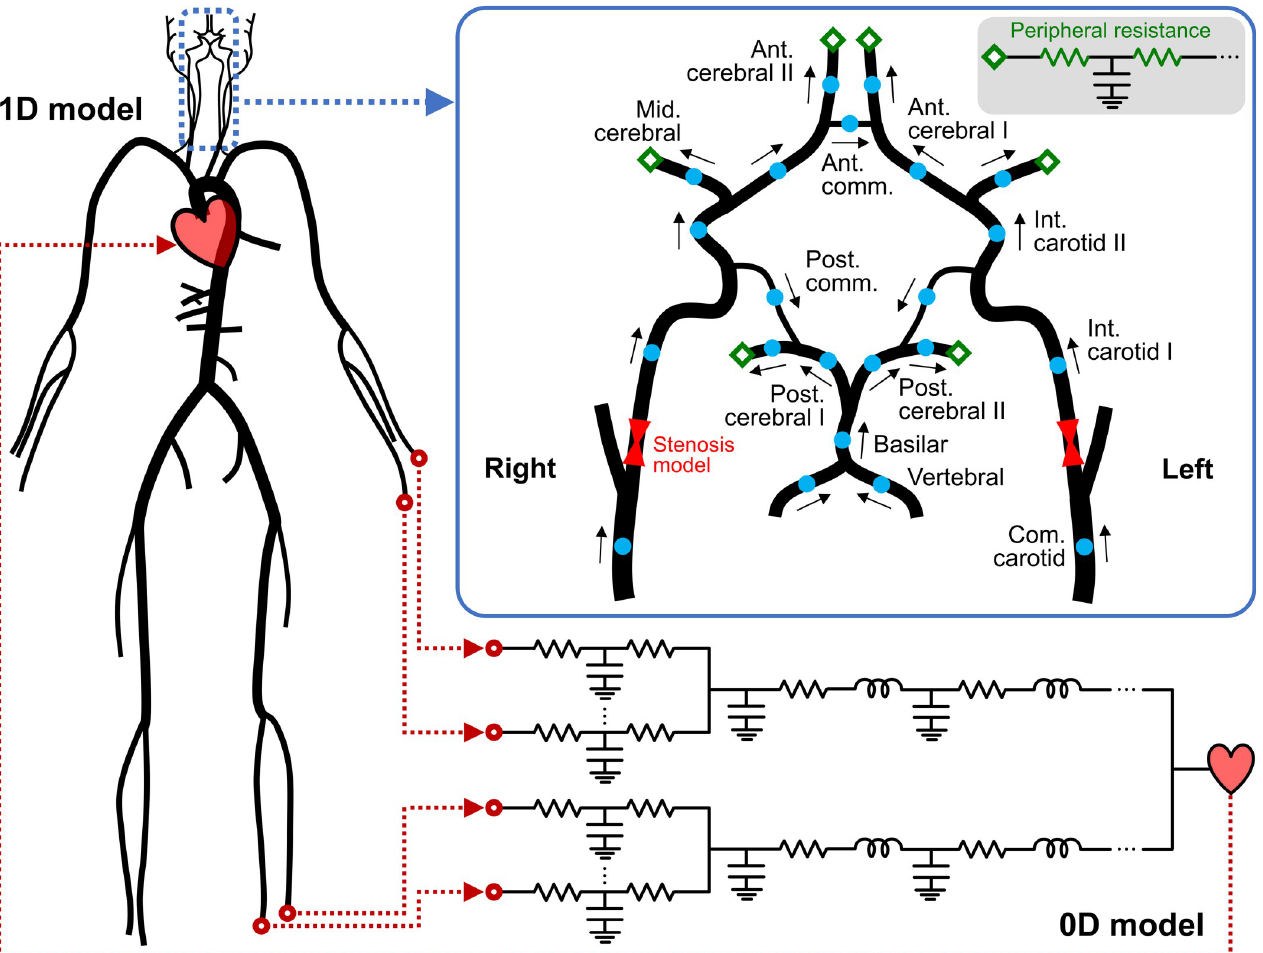
Fig 2. Schematic representation of the one-dimensional–zero-dimensional (1D–0D) model. The 1D network comprises 83 arterial segments, including 22 segments (blue dots) composing the cerebral circulation. Cerebral arteries form a ring-like network, referred to as the circle of Willis, which supplies blood to the brain through the six outlets (green diamonds). The arrows indicate the direction of the flow defined as positive in the simulation. The inlet and outlet boundary conditions for the 1D network are obtained by coupling with the 0D closed-loop model, which represents the peripheral circulation and heart.